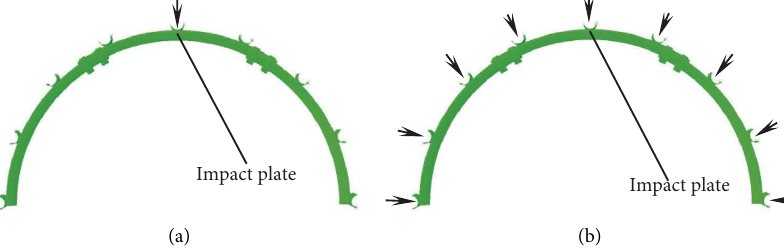
Figure 7: Loading method and measuring point. (a) Concentrated load action and (b) uniform load action.